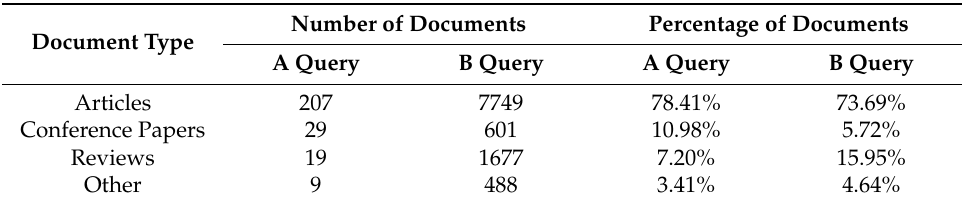
Table 4. Types of documents.